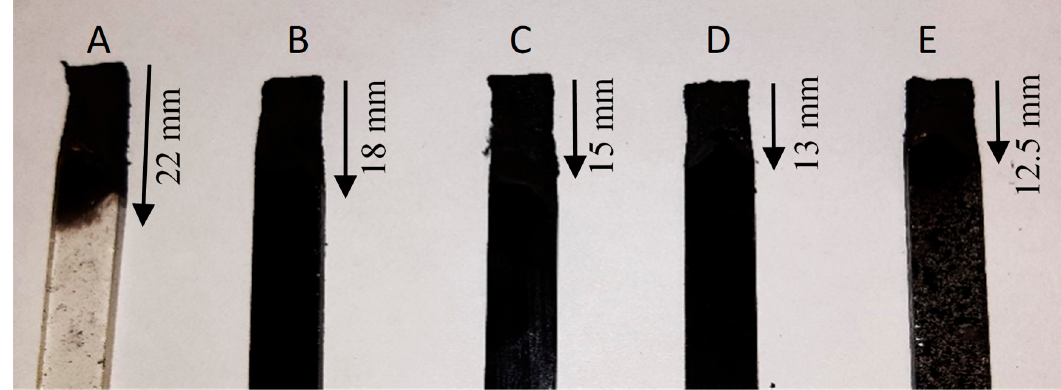
Figure 12. The samples after the burning test ( A ) 0%P + 0%L, ( B ) 0%P + 5%L, ( C ) 0%P + 5%LP, ( D ) 2%P + 5%L, ( E ) 2%P +